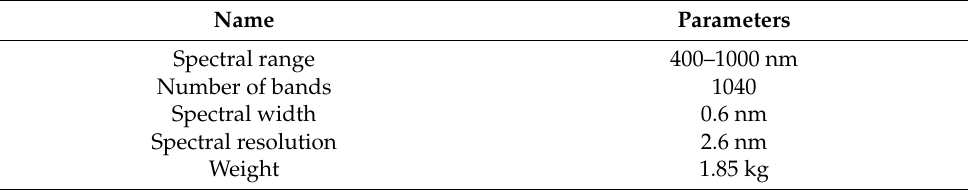
Table 2. Specifications of hyperspectral imaging spectroradiometer